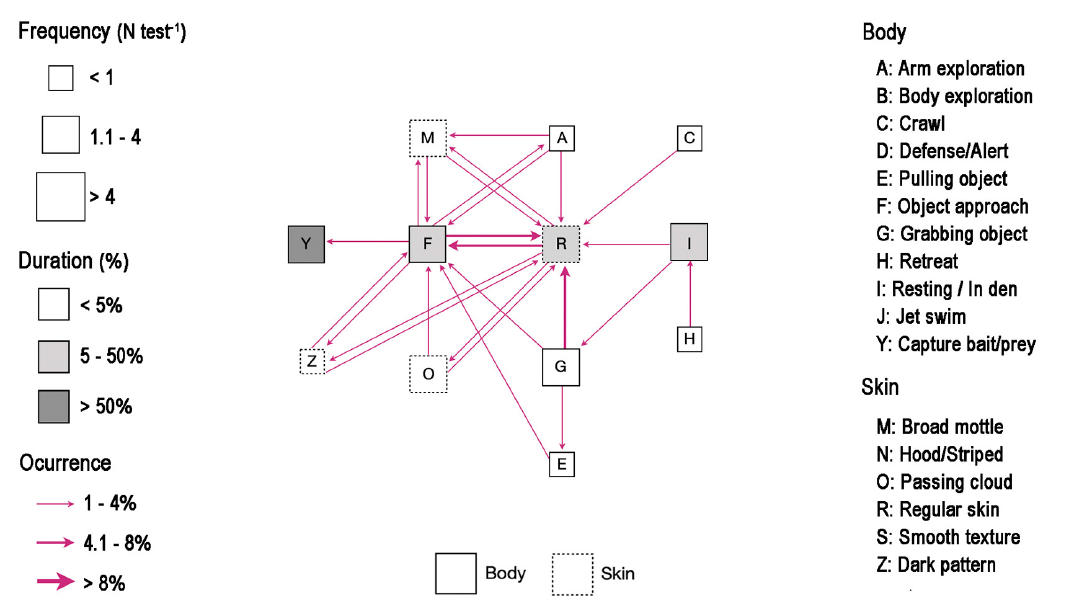
Fig. 2. – Kinematic diagrams of general behaviours and body patterns of all O. vulgaris observed during the experiment. The size and colours of bounding boxes around the behaviours is proportional to the relative frequency and duration of a particular behavioural pattern, respectively. Paired behaviour sequences are depicted as arrows. The magnitude of the occurrence of each paired sequence is shown by the arrow size. Transitions that occurred less than 1% (<0.01) of the time during an interaction were excluded. The continuous line squares show the body posture and movements, whereas the discontinuous line squares show the skin